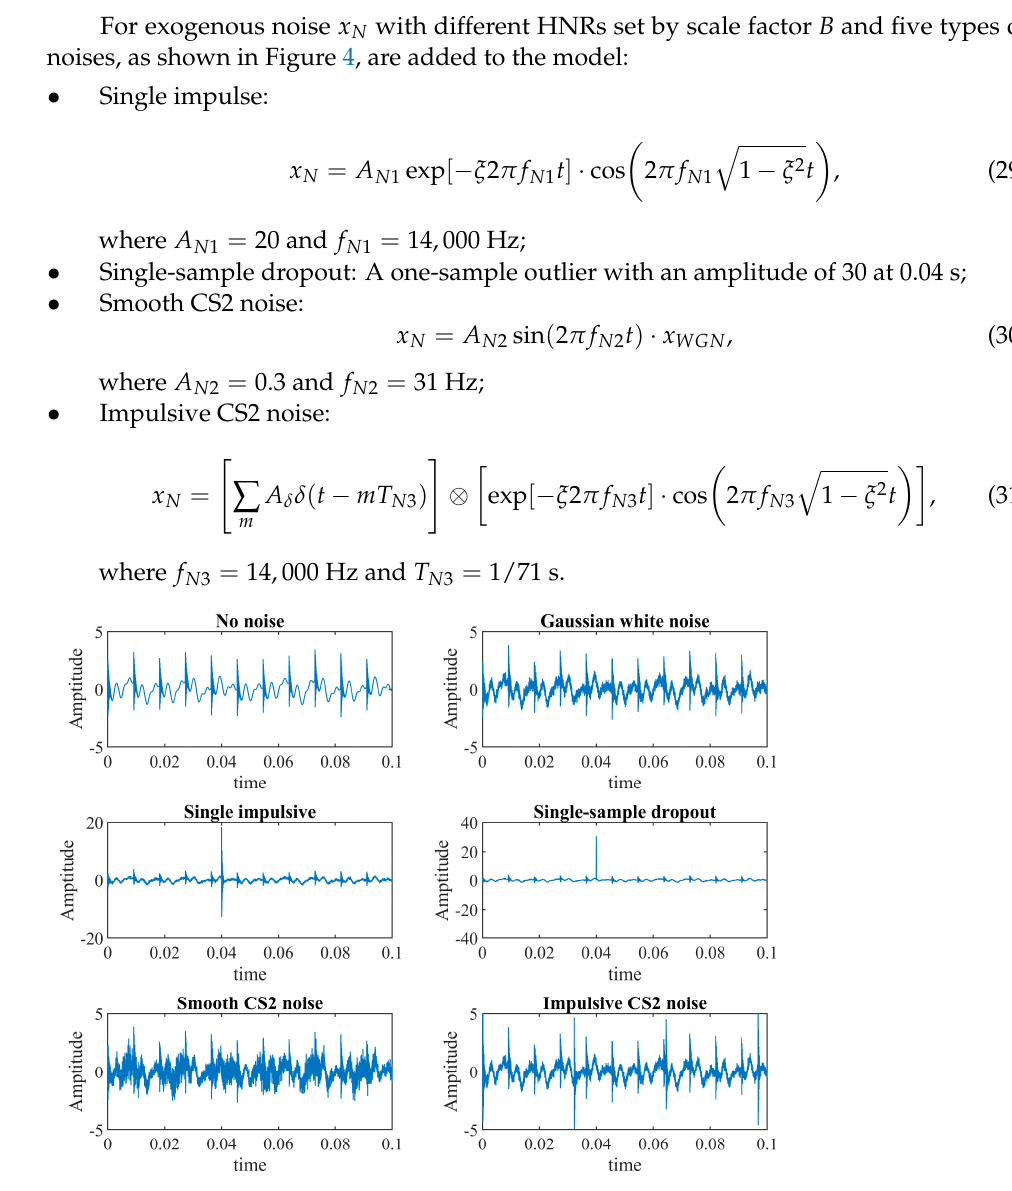
Figure 4. Different exogenous noises.